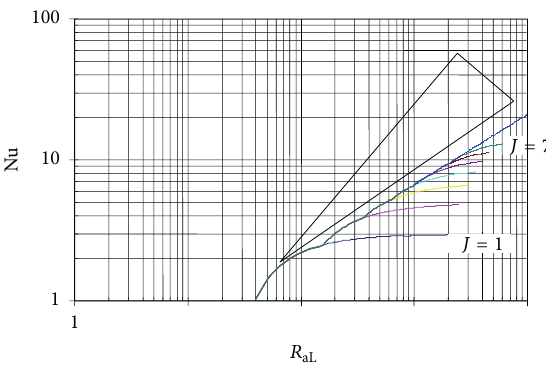
Figure 7: Nusselt number based on stability limits for 𝑃(0, 2𝑗) for 𝐽 unstable modes. The triangle shows approximate location of Nu– 𝑅 test results reported by [1–3, 7, 18,